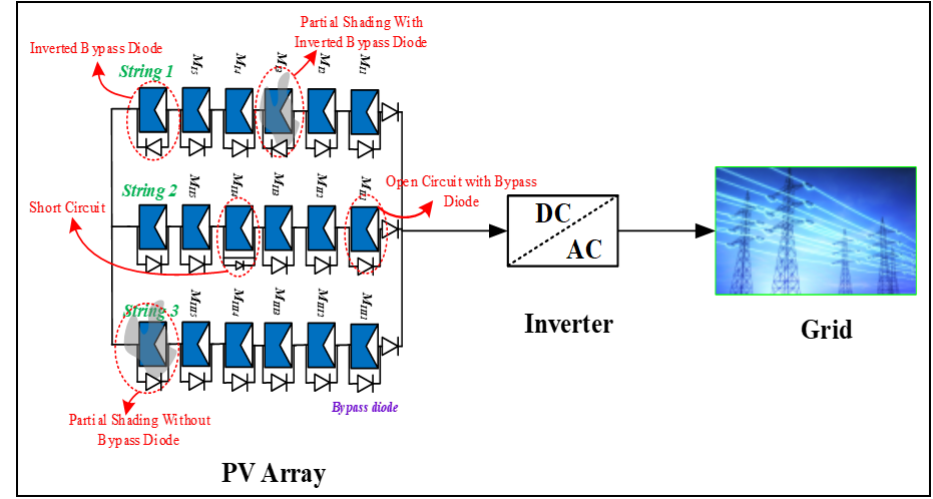
Figure 3. Locations of various faults created on a 6 × 3 grid-tied PV array.